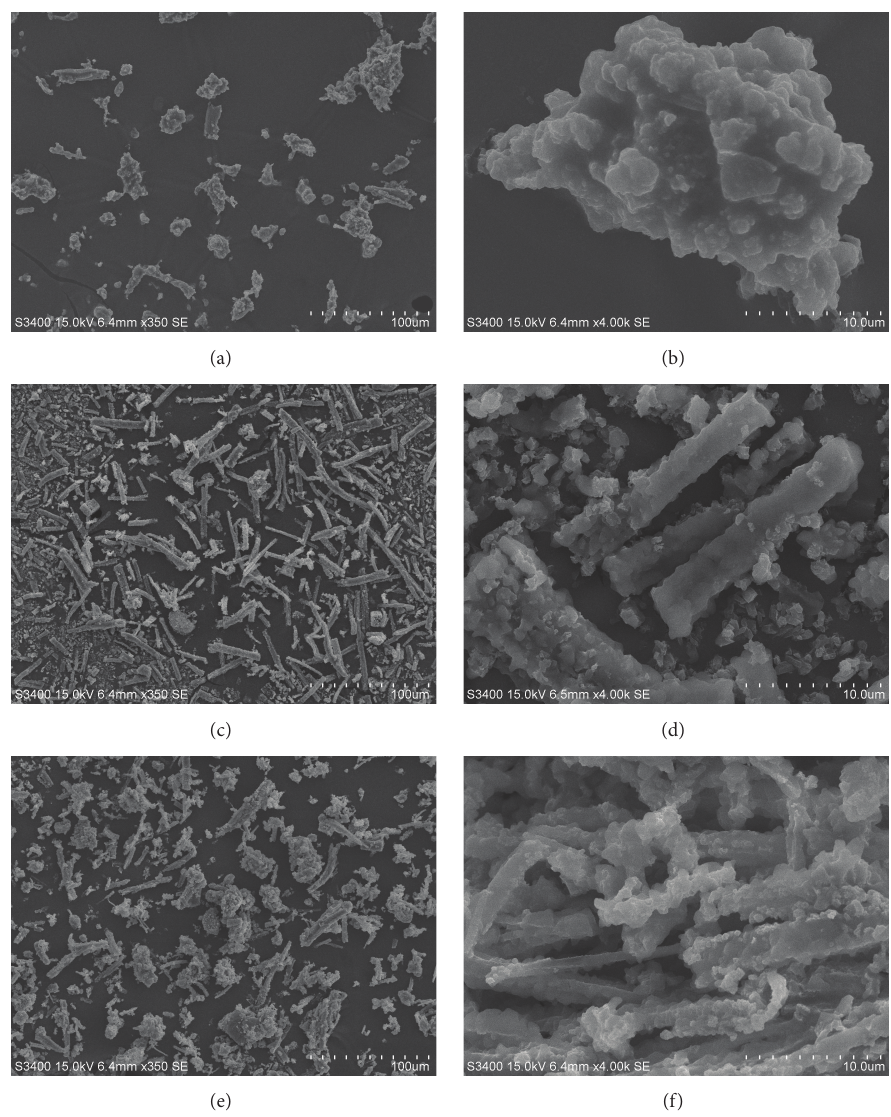
Figure 3: SEM images of prepared catalysts: ((a), (b)) None-THF, ((c), (d)) Al-THF, and ((e), (f))